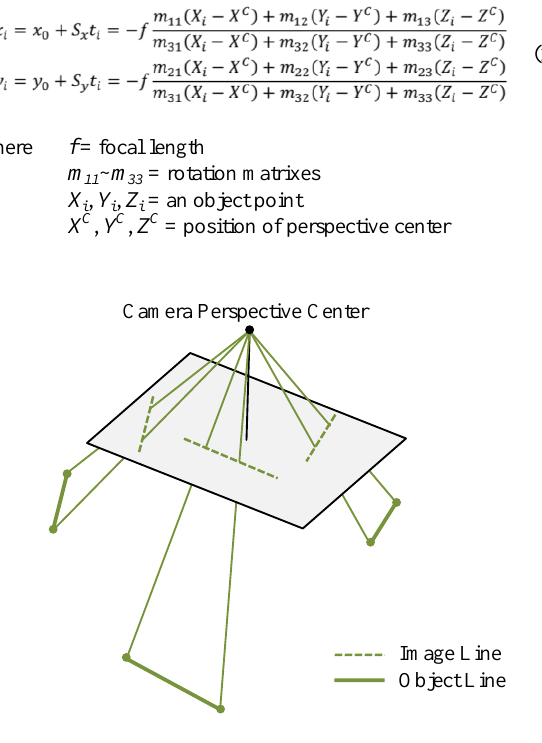
Figure 2. Line-based orientation